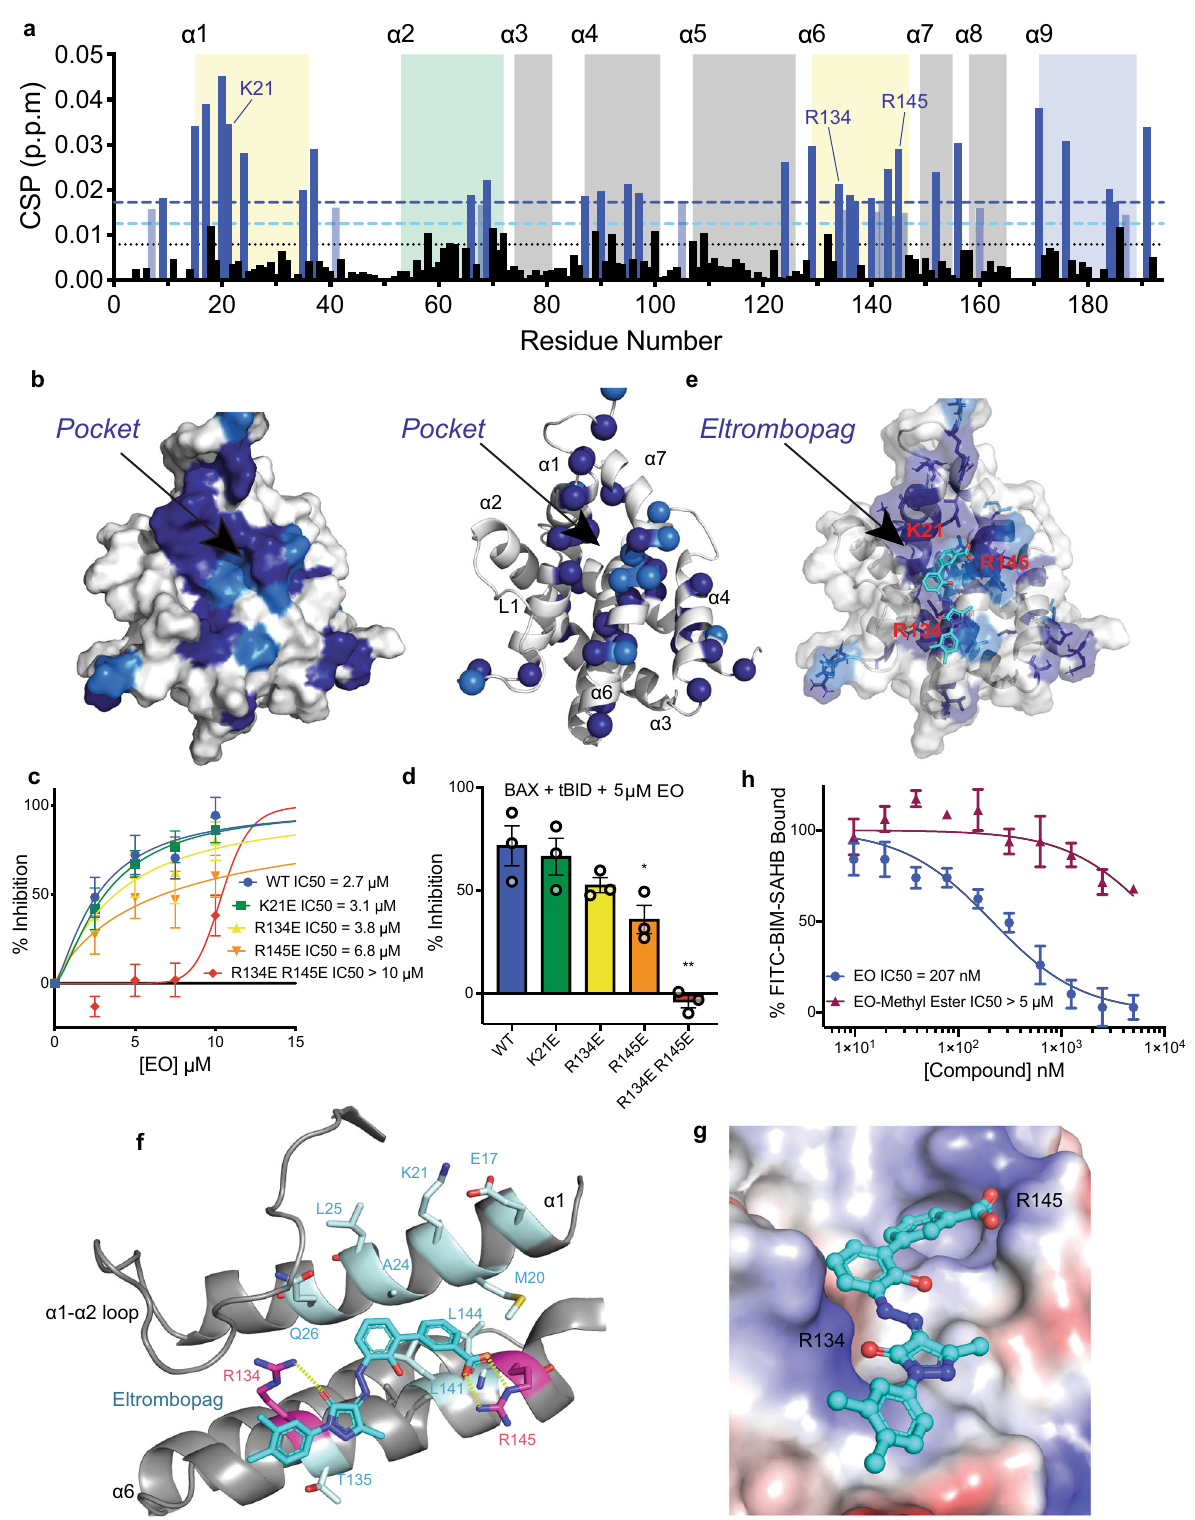
We set out to determine which EO pose was appropriate by comparing BAX trigger site mutants that would eliminate one of the three basic trigger site residues, K21E, R134E, or R145E, to wild-type (WT). All tested mutants exhibited identical retention time in size-exclusion chromatography analysis, suggesting no effect on BAX folding and had comparable purity and molecular weight to WT BAX as determined by SDS-PAGE (Supplementary